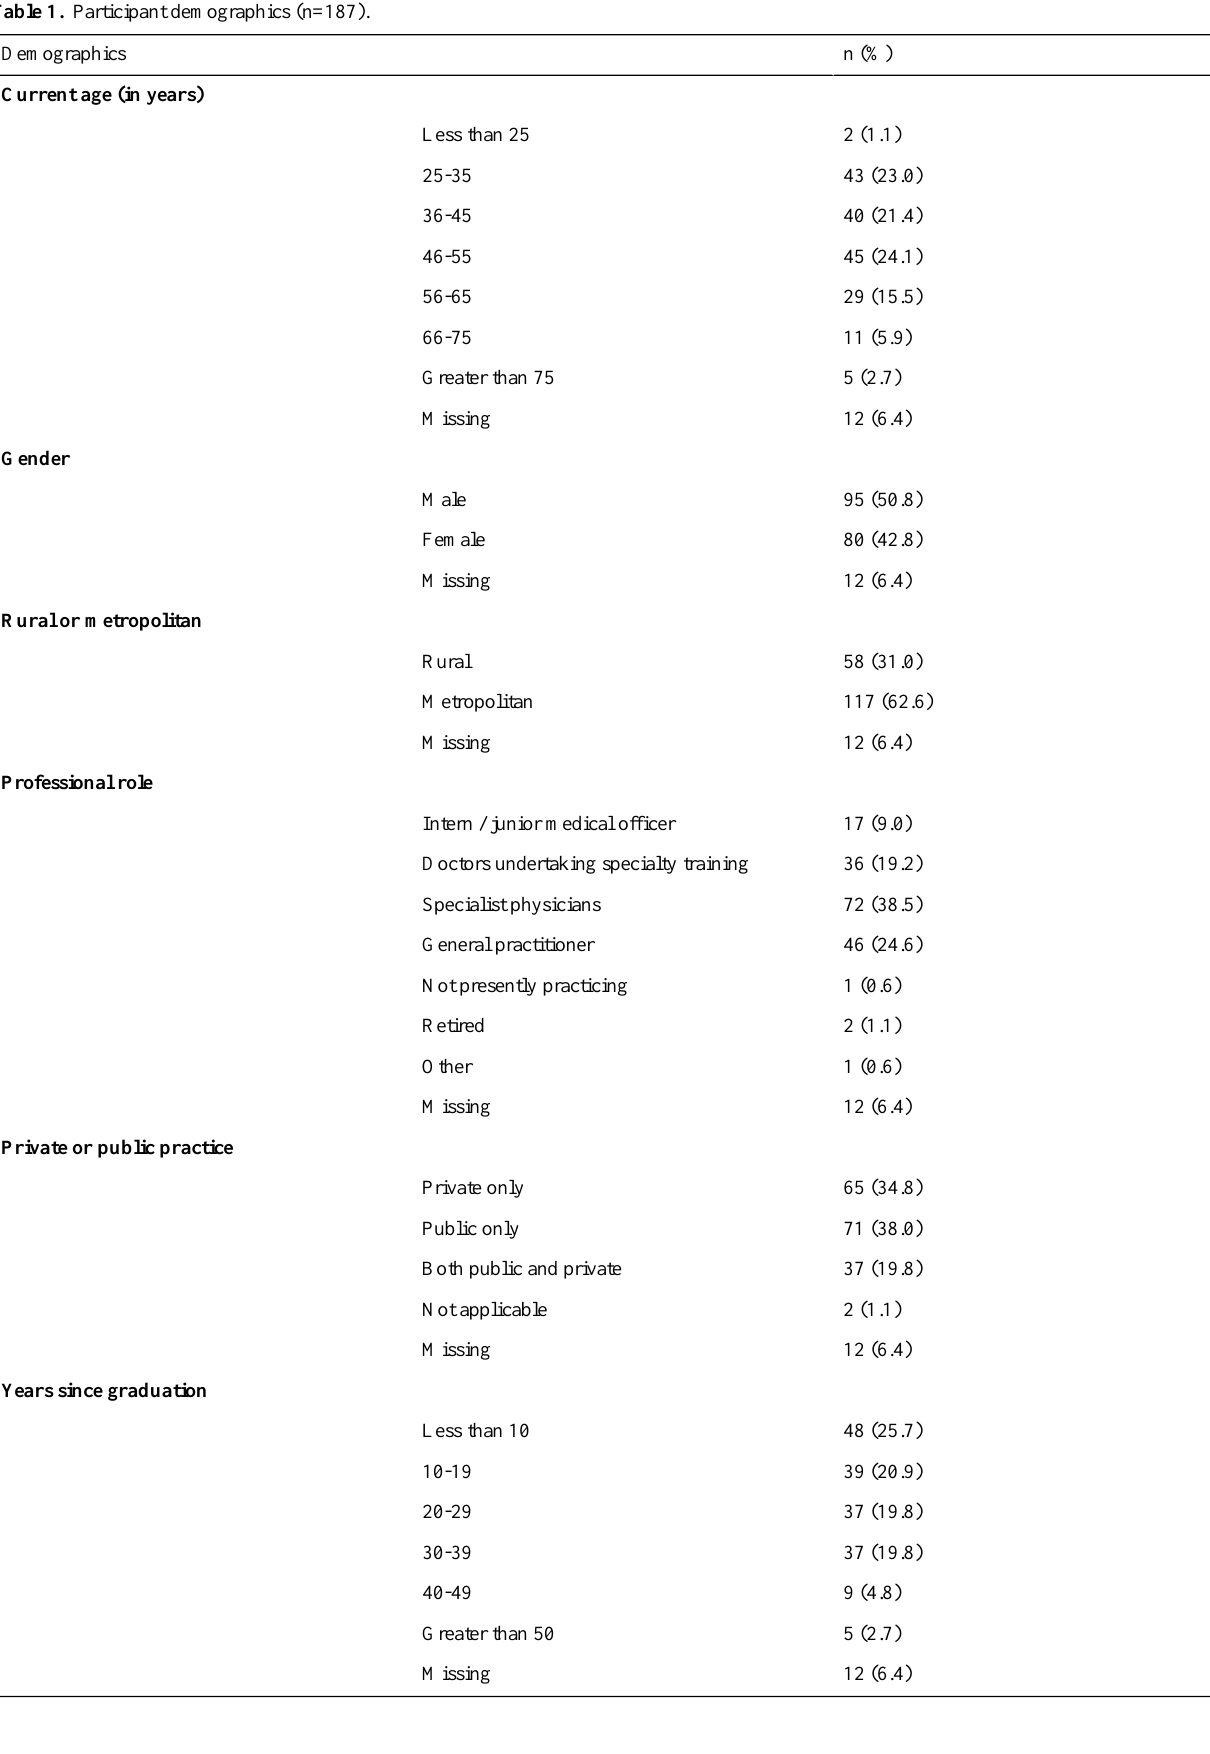
Table 1. Participant demographics